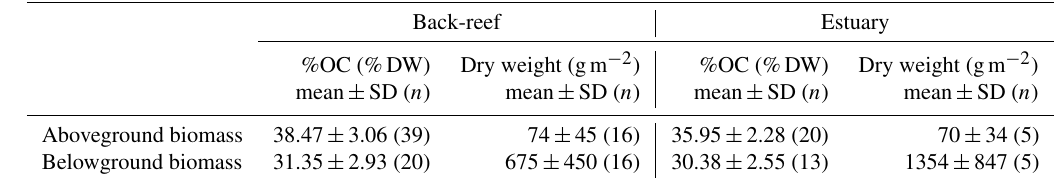
Table 1. Organic carbon contents and dry weights of each component of living biomass at the back-reef and estuarine sites. Back-reef Estuary